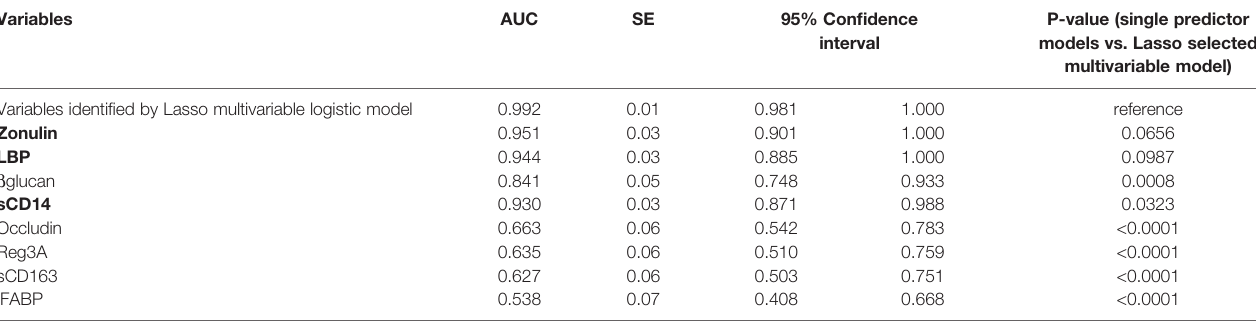
TABLE 2 | Results of logistic regression models of tight junction permeability and microbial translocation markers for ability to distinguish hospitalized from non- hospitalized individuals. Variables AUC P-value (single predictor